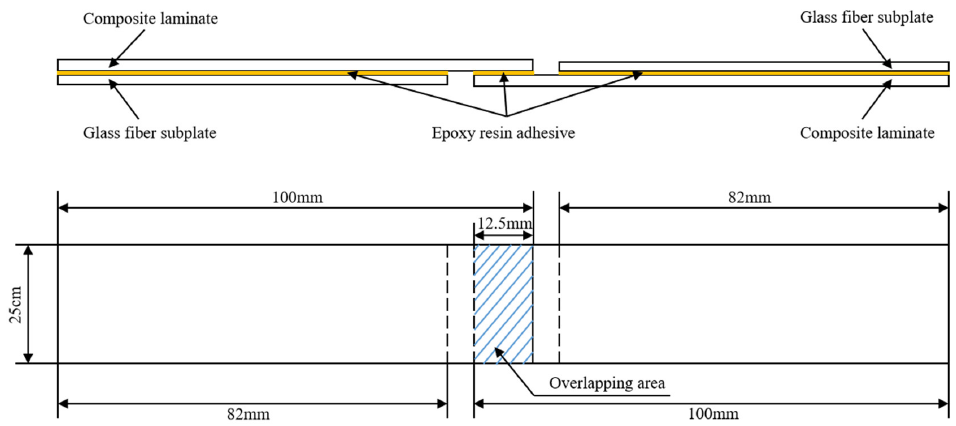
Figure 1. Schematic diagram of bonding process and final sample size.